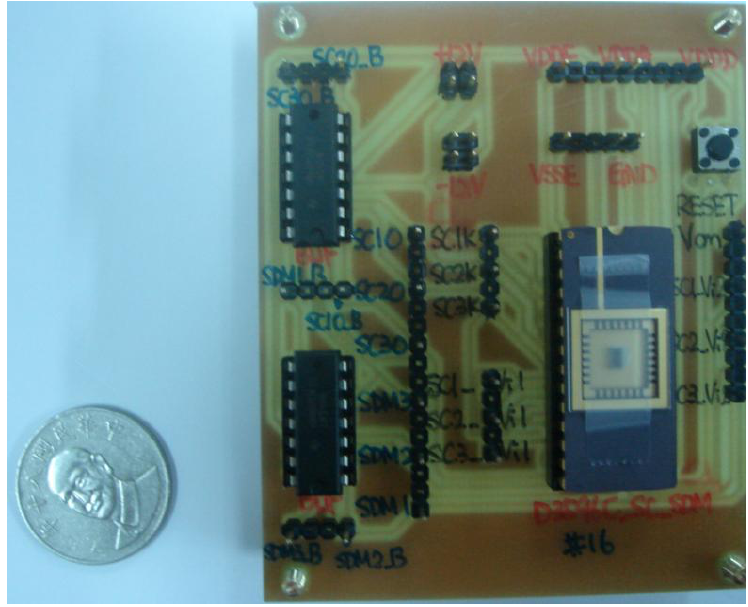
Figure 23. Photograph of the test PCB.